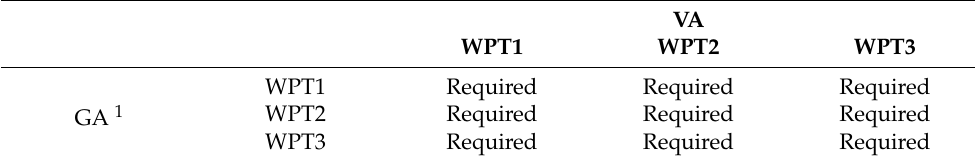
Figure 3. Process of interoperability standardization. Table 1. Interoperability requirements of various power classes.